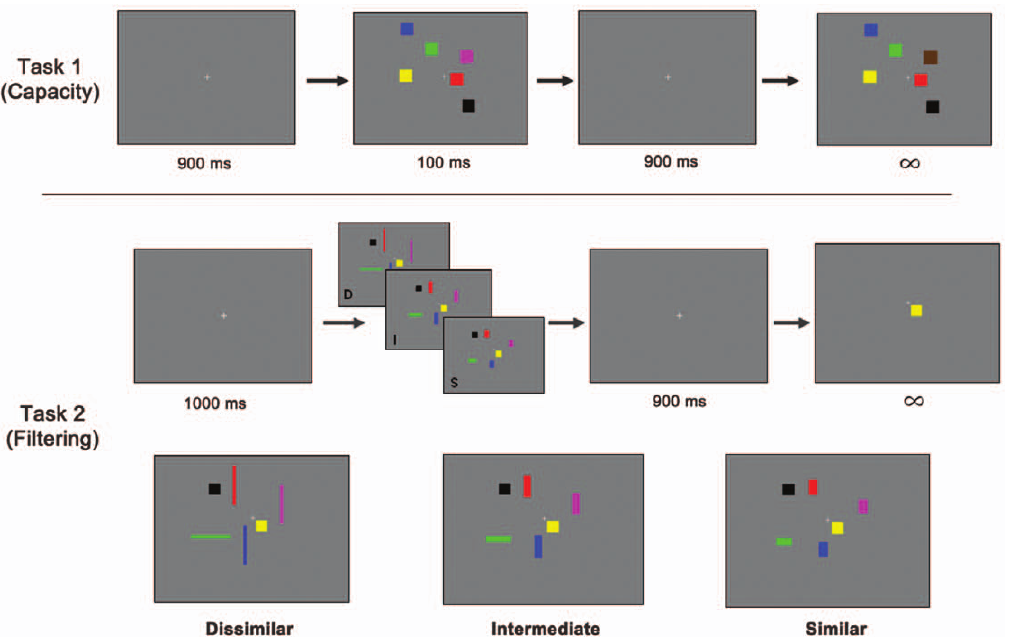
Figure 2. VWM Capacity and Filtering Tasks. These are examples of stimuli from each task. Participants always took Task 1 (VWM Capacity) before Task 2 (Filtering). Dissimilar, Intermediate and Similar distractors are each progressively more difficult to discern from target squares.